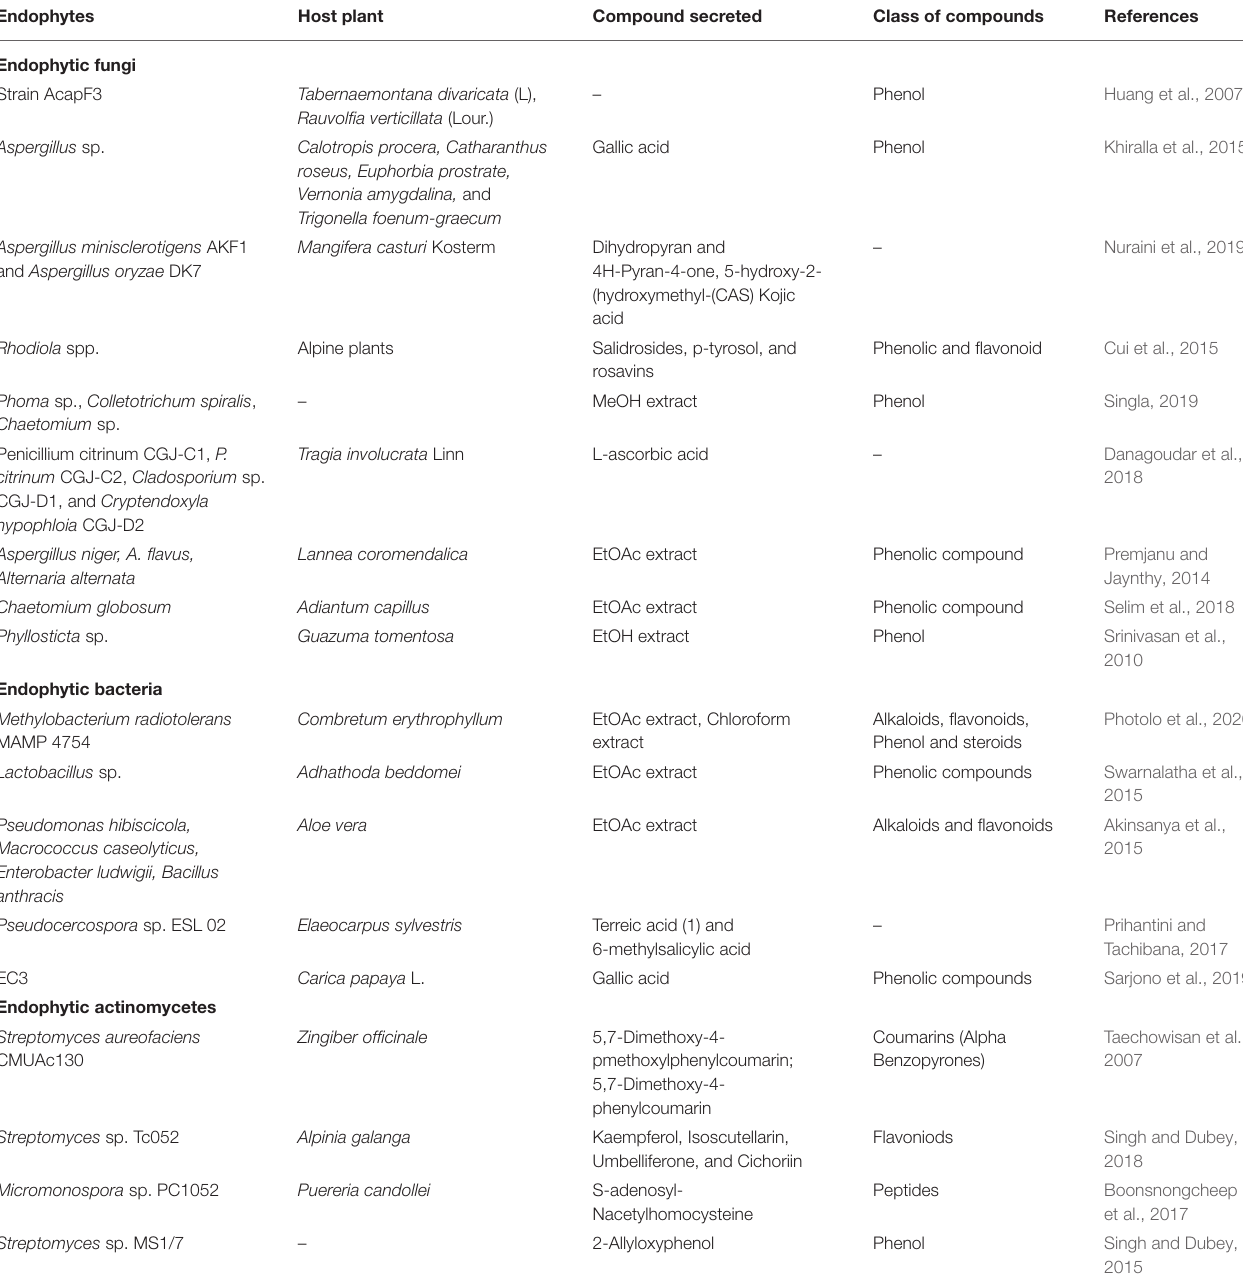
TABLE 3 | Summary of studies of antioxidant properties of